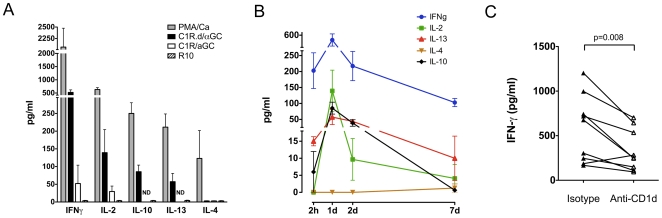
Cytokine production by ex vivo peripheral blood NKT lymphocytes in sooty mangabeys.A) Cytokine ELISA for IFN-γ, IL-2, IL-10, IL-13, and IL-4 with culture supernatants collected 24 hours post-stimulation of PBMC (mean and SEM of 4 to 7 animals). B) Kinetics of cytokine secretion in PMA/Ca and C1R.d/α-GC stimulated PBMCs at 2 hour, 1 day, 2 days, and 7 days post-stimulation. C) IFN-γ production in C1R.d/α-GC stimulated lymphocytes in the presence of anti-human CD1d (clone 42.1) blocking antibody or isotype control Ab.